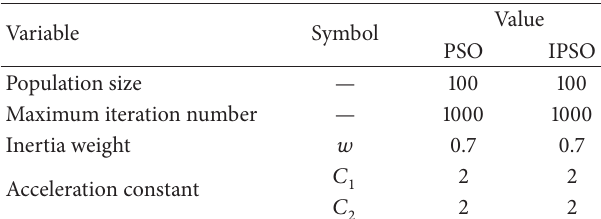
Table 1: PSO and IPSO parameters.